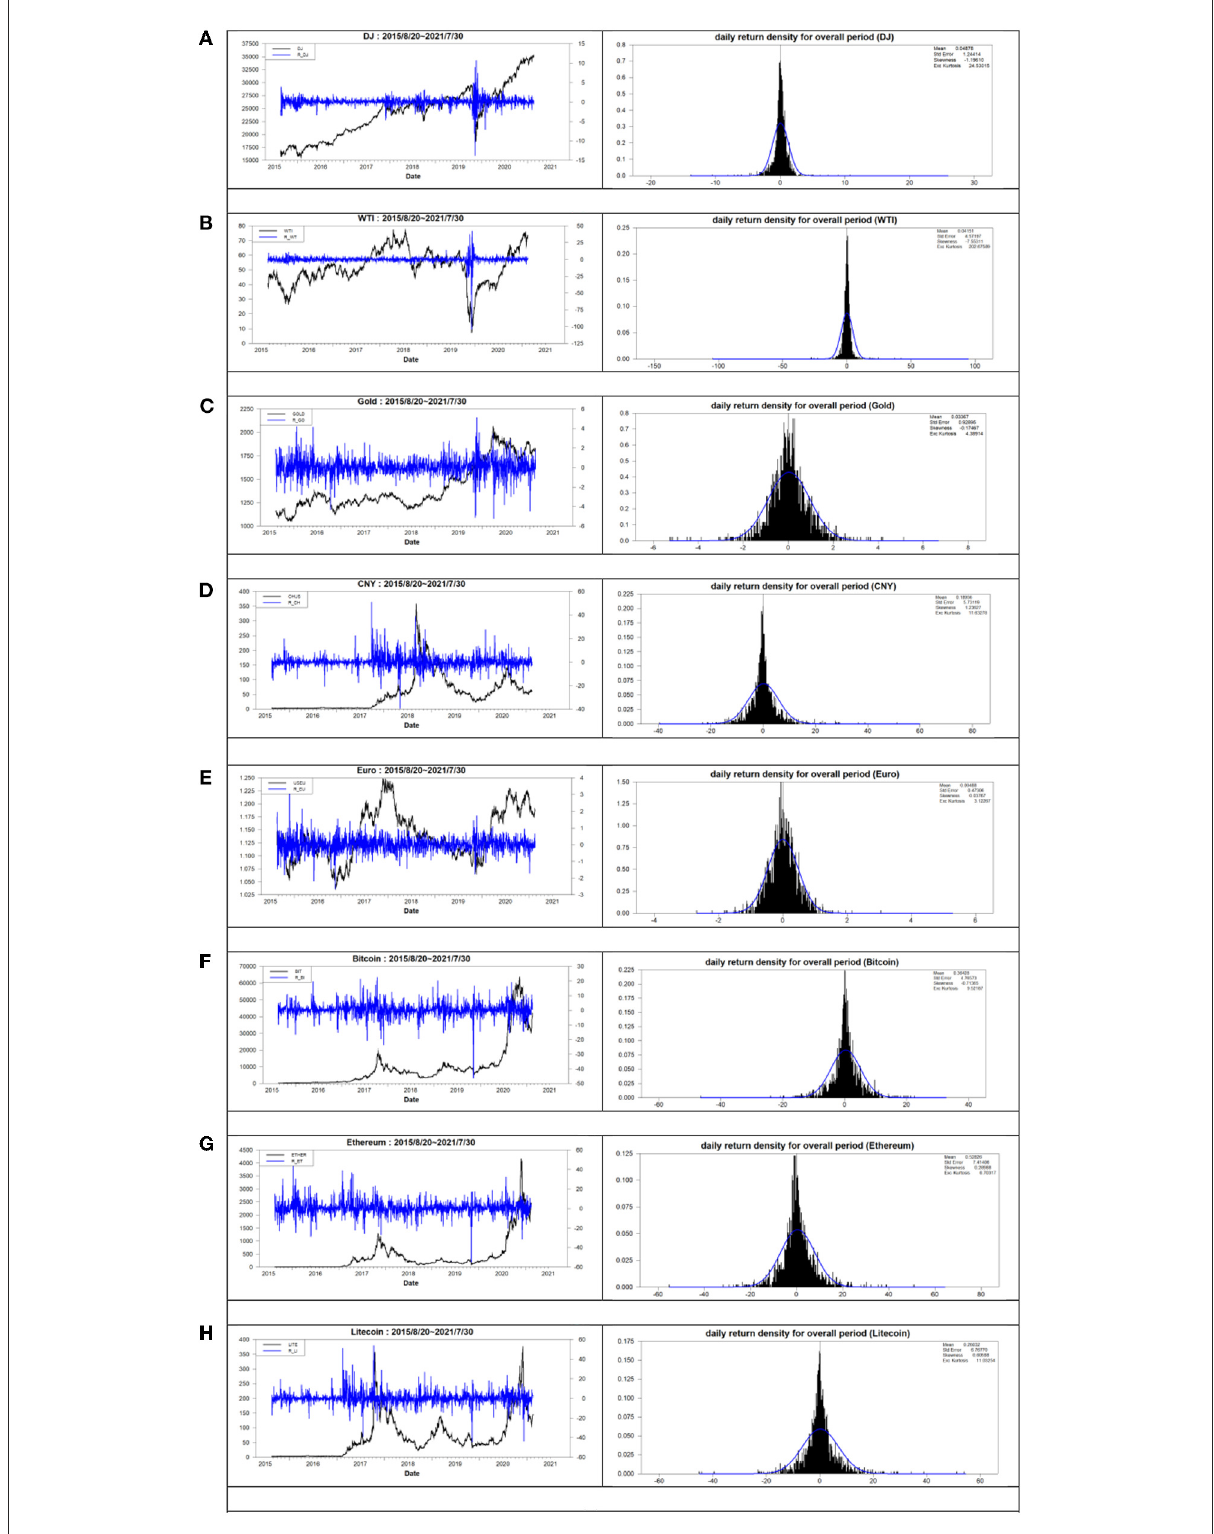
FIGURE1 The price level, return, and daily return density for the overall period. (A) DowJones, (B) WTI, (C) Gold, (D) CNY, (E) Euro, (F) Bitcoin, (G) Ethereum, and (H)